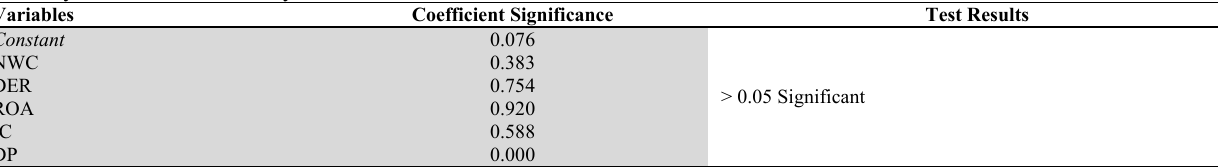
Summary of Heteroskedasticity Tests